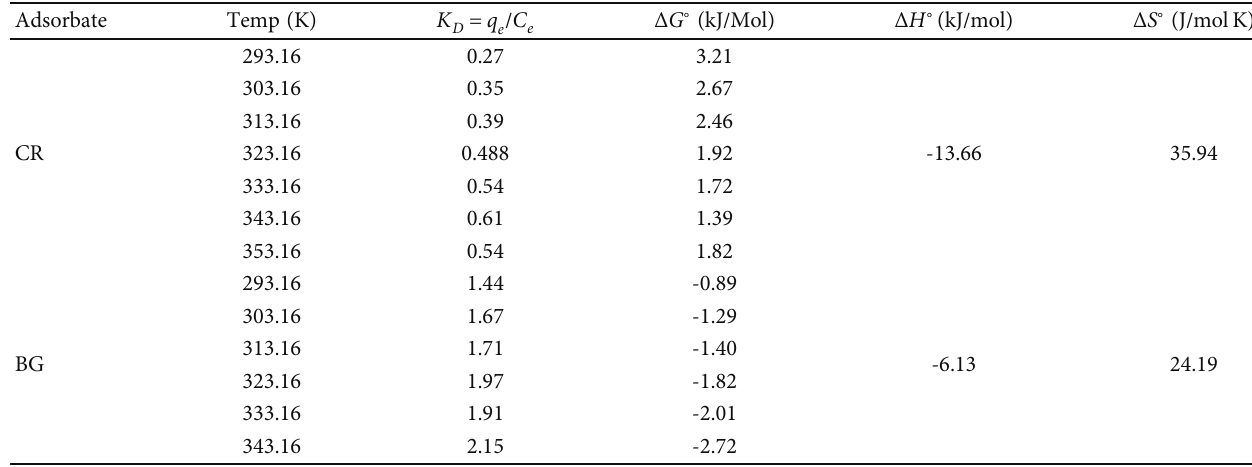
Table 5: Thermodynamic parameters of dyes removal by BO